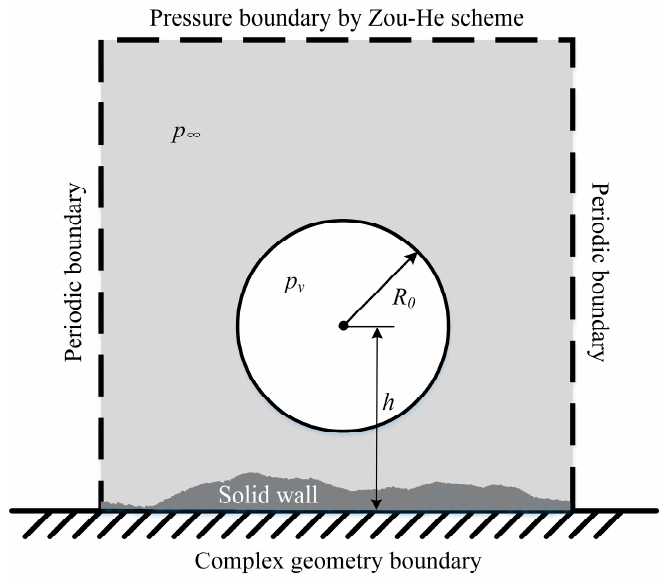
Figure 2. Computational domain.